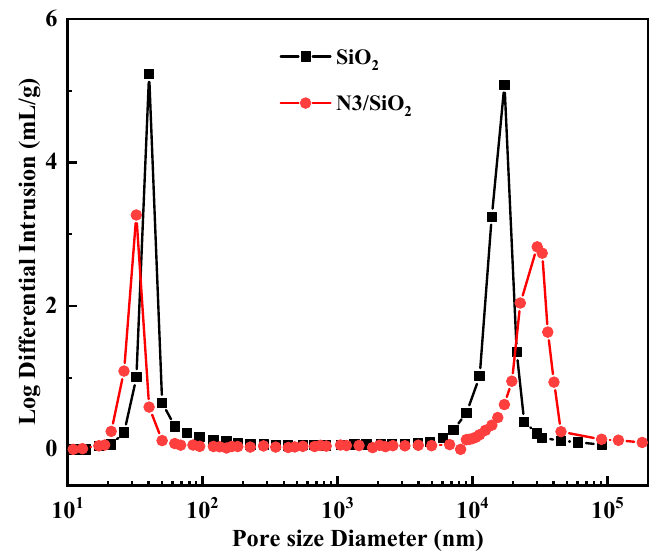
Figure 3. The pore size distribution of SiO 2 and N3/SiO 2 . Table 1. The pore size and porosity of SiO 2 and N3/SiO 2 .